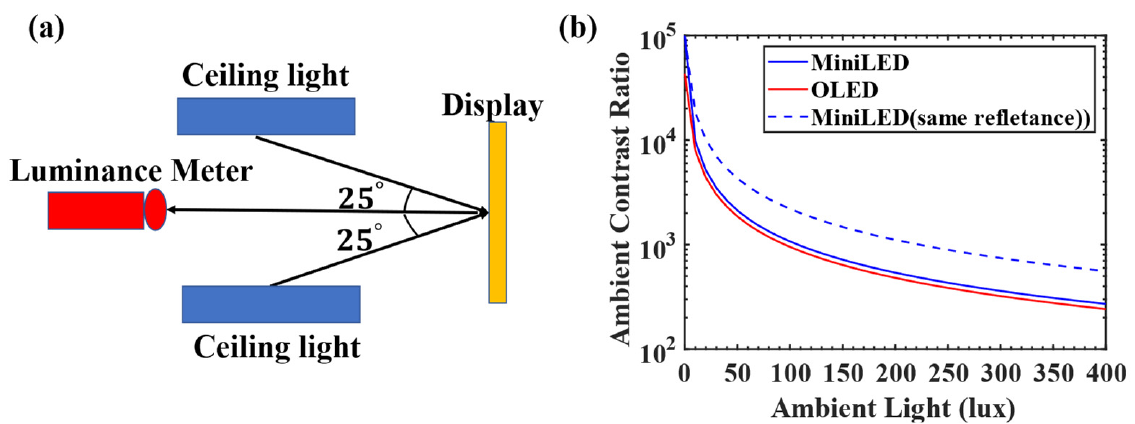
Figure 7. ( a ) Top view of the ACR measurement setting. ( b ) Measured ACR of the mLCD and OLED panels.